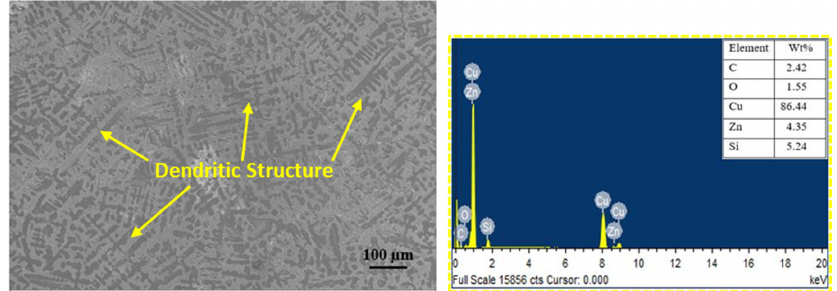
Figure 4. FESEM micrograph and EDX analysis of Cu alloy matrix. Appl. Sci. 2023 , 11 , x FOR PEER REVIEW